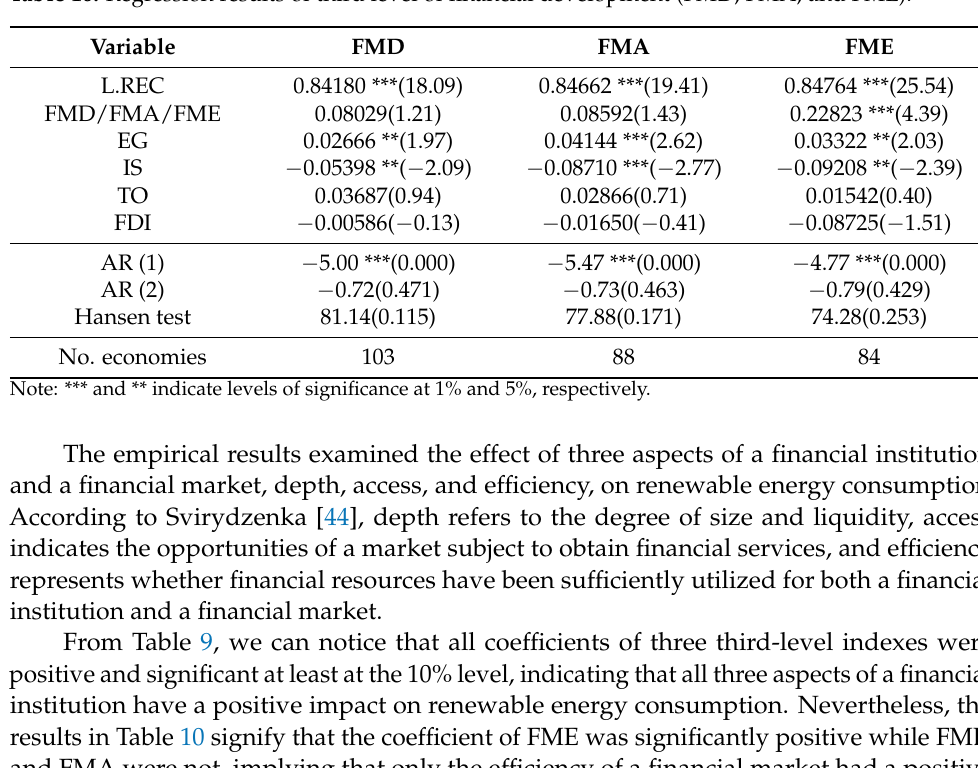
Table 10. Regression results of third level of financial development (FMD, FMA, and